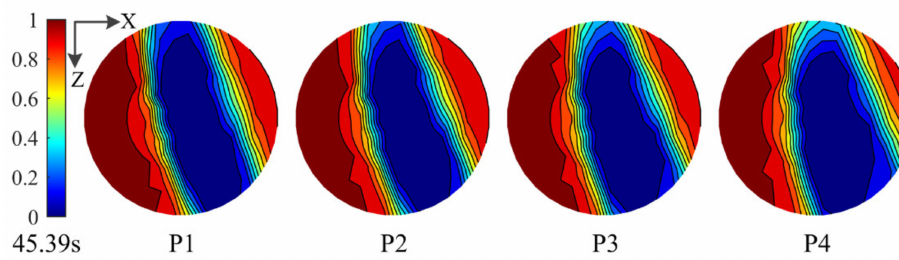
Figure 22. The compression damage of concrete in the core area at 44.08 s.